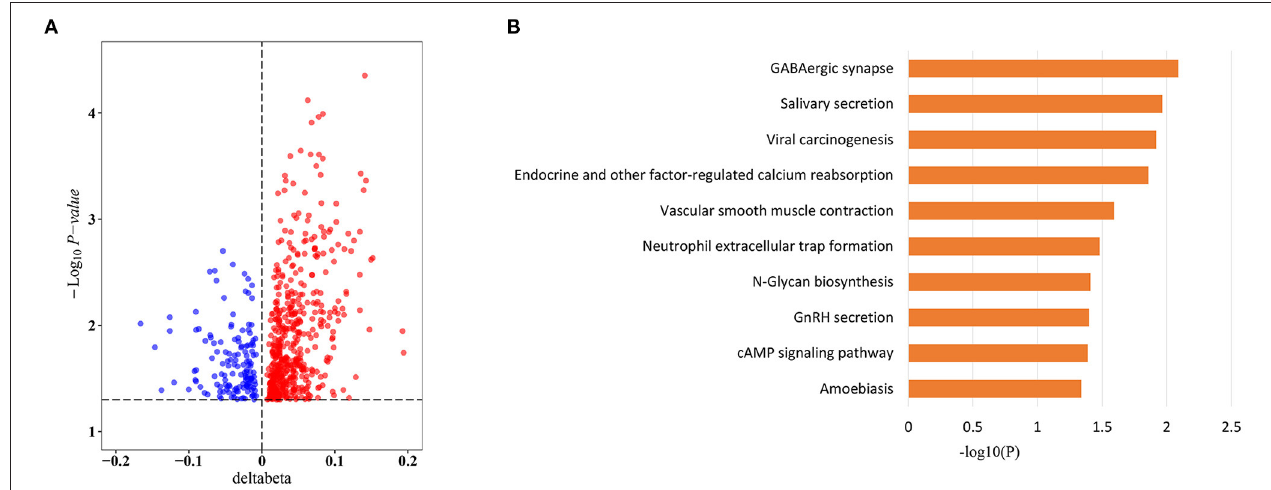
FIGURE 3 | Sepsis outcome-related CpG sites. (A) Volcano plot of sepsis outcome-related CpG sites ( n = 657). (B) Kyoto Encyclopedia of Genes and Genomes (KEGG) pathway enrichment analysis of sepsis outcome-related CpG